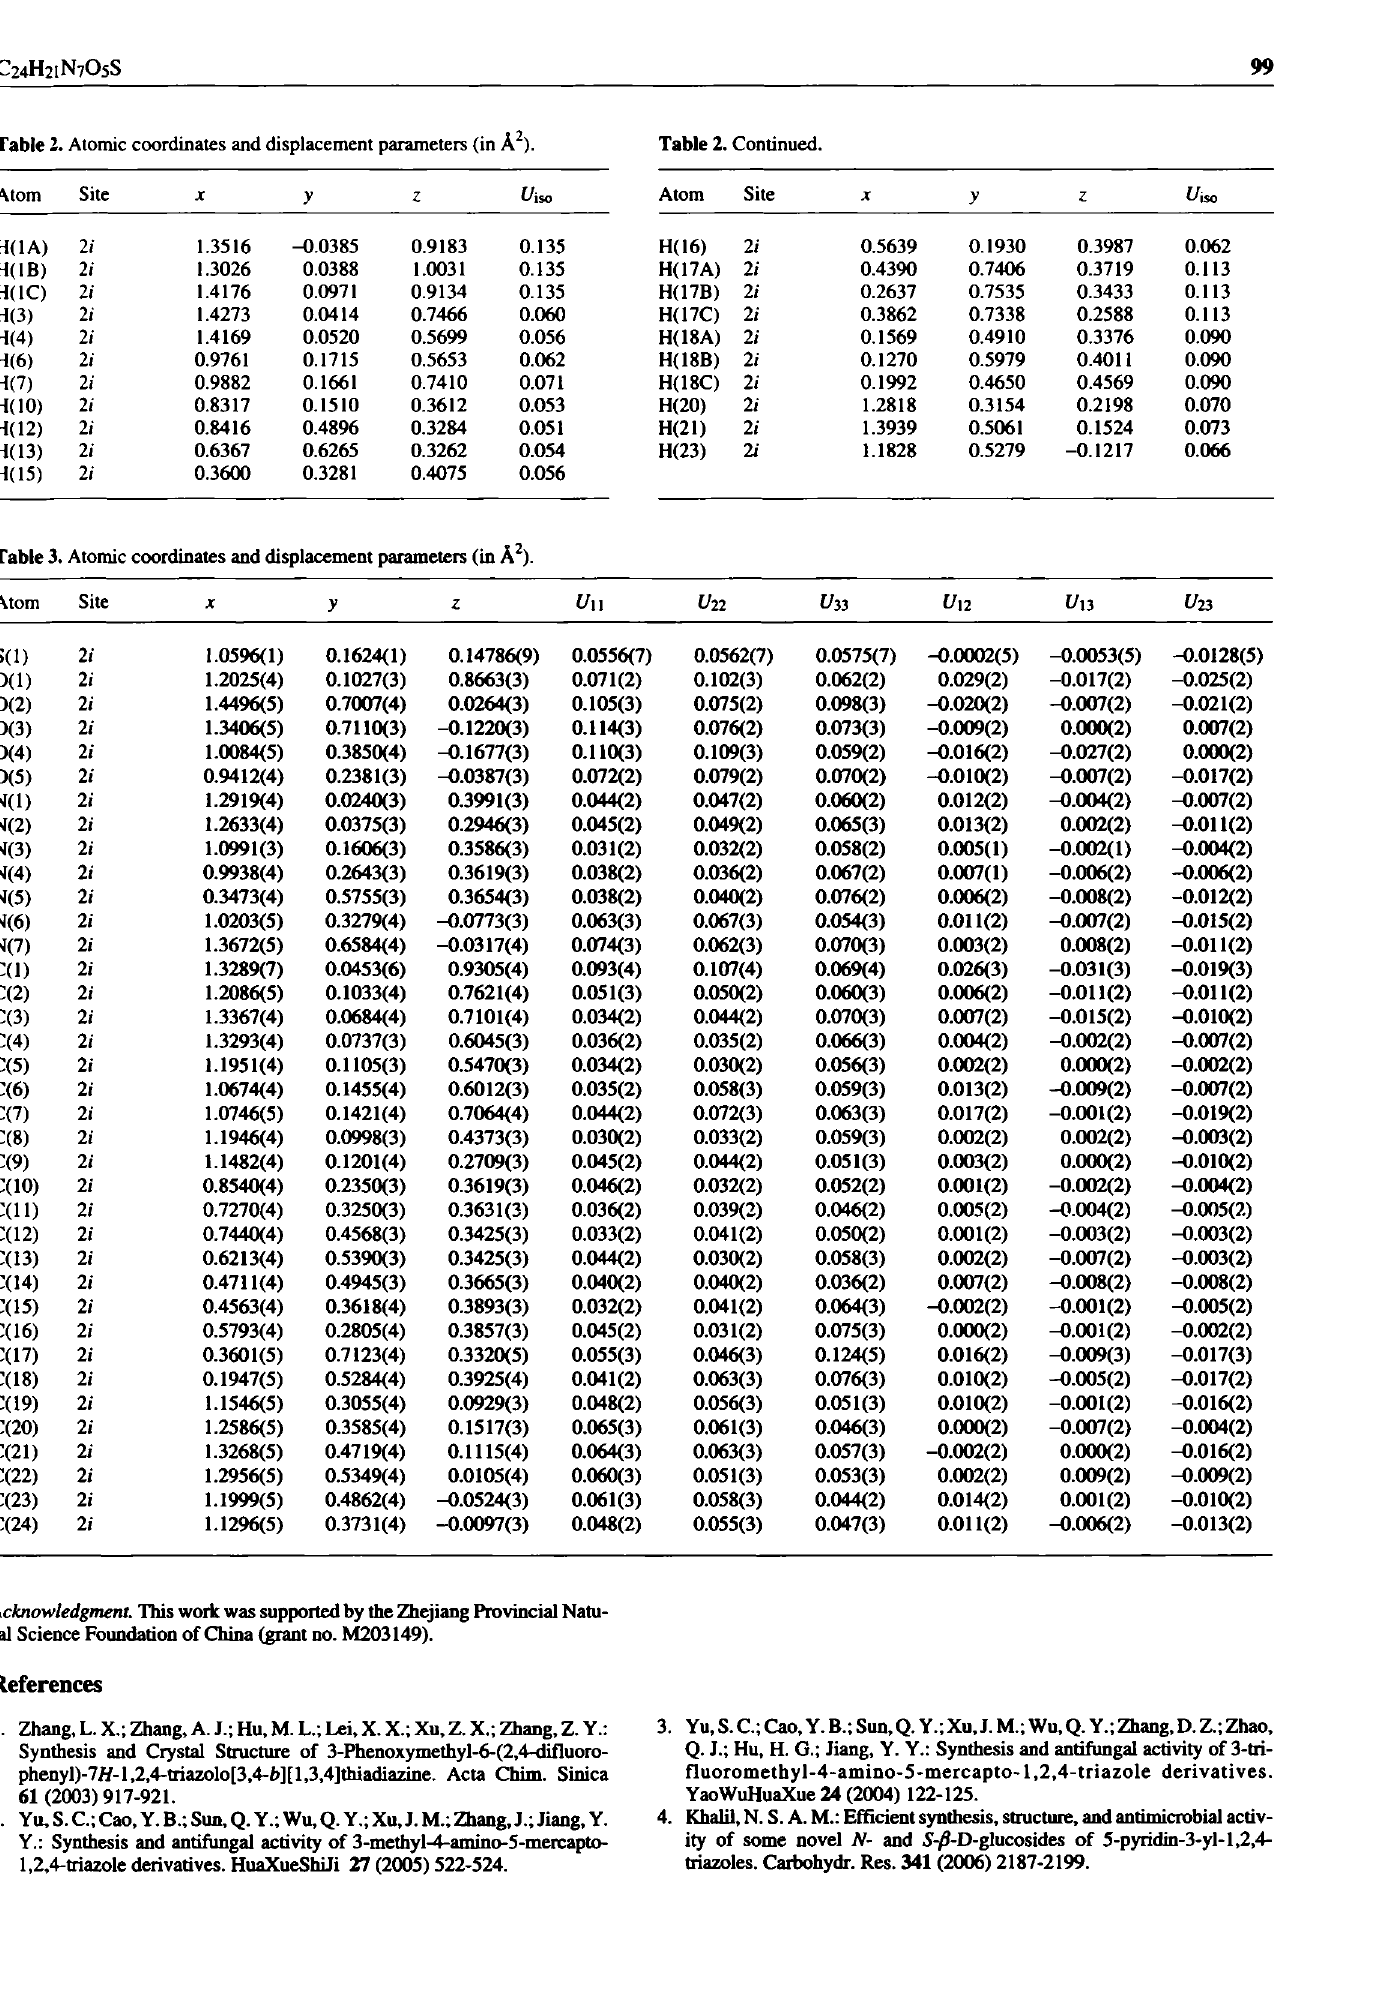
Table 2. Atomic coordinates and displacement parameters (in Â 2 ).